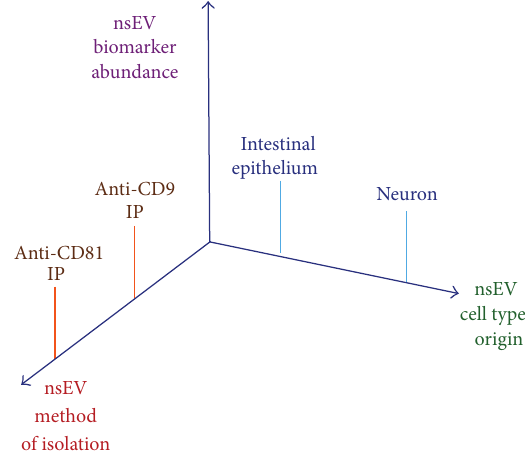
Figure 1: Three-dimensional nsEV phenotyping Cartesian coordi- nate system. The 𝑥 -axis defines nsEV method of nsEV isolation dimension; anti-CD9 IP and anti-CD81 IP are denoted as two rep- resentative 𝑥 -axis points. The 𝑦 -axis defines nsEV cell type origin dimension;intestinalepitheliumandneuronaredenotedastworep- resentative 𝑦 -axis points. The 𝑧 -axis defines biomarker abundance dimension. The 𝑧 -axis units will vary depending upon the method used to quantify biomarker abundance(s); no representative 𝑧 -axis points are denoted in this